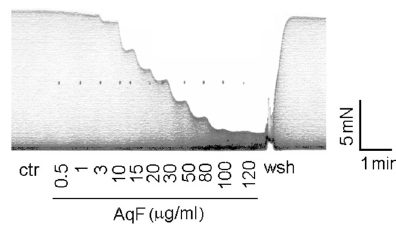
FIGURE 1 - Typical experimental record showing the contractile depressant effect of AqF on the guinea pig left atrium (ctr: control; wsh: washout; 27 ± 0.1 ºC; Stimulation: 2 Hz, 400 V, 0.5 msec).